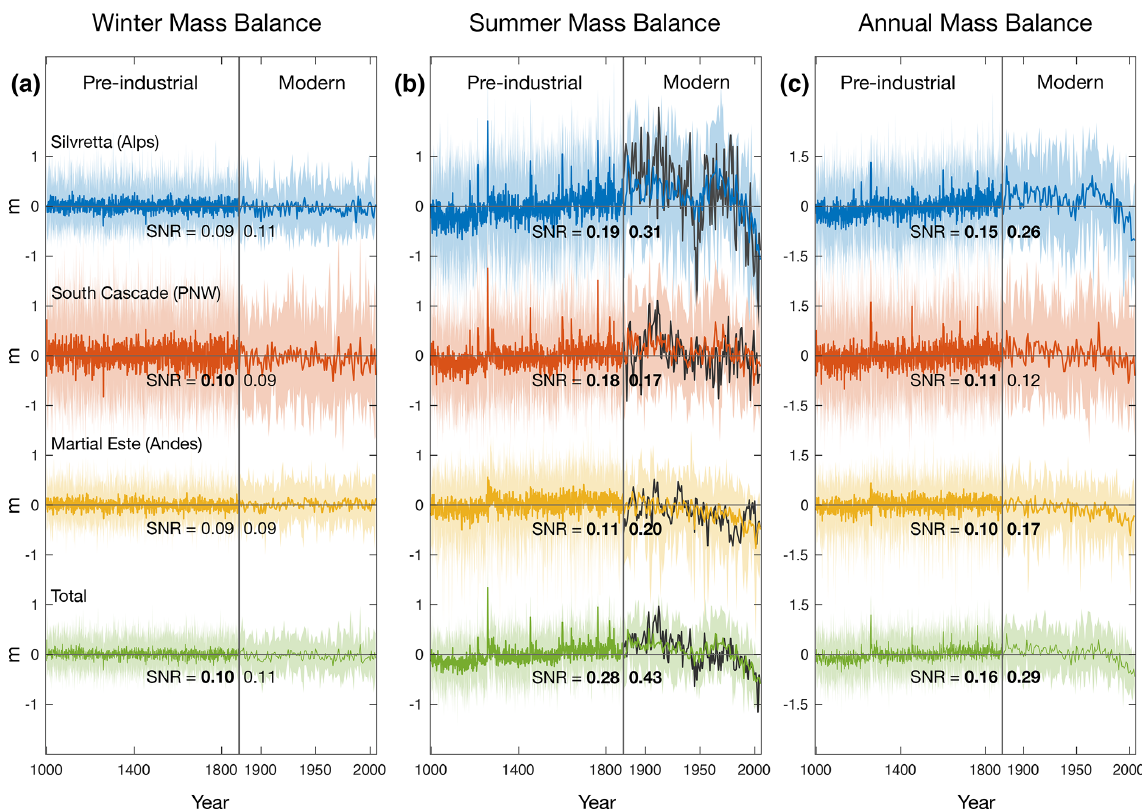
Figure 1. One thousand years of mass-balance anomalies modeled using the LME output, for three different locations. (a) Winter mass balance, (b) summer mass balance, and (c) annual mass balance in the Alps (blue), the Pacific Northwest (red), and the Patagonian Andes (yellow), along with their average (green). Heavy colors represent the ensemble mean, while lighter colors represent individual ensemble members. The vertical gray line at the year 1880 marks the approximate transition from the pre-industrial era to the modern era, after which the time axis on each panel is dilated by a factor of 4 to enhance visibility. To evaluate the accuracy of LME temperatures over the modern era, we also plot values of b (cid:48) s calculated from the observational NASA-GISS surface temperature data set in black. SNR values are given for each glacier and era, with bold font indicating statistical significance (99% confidence; see